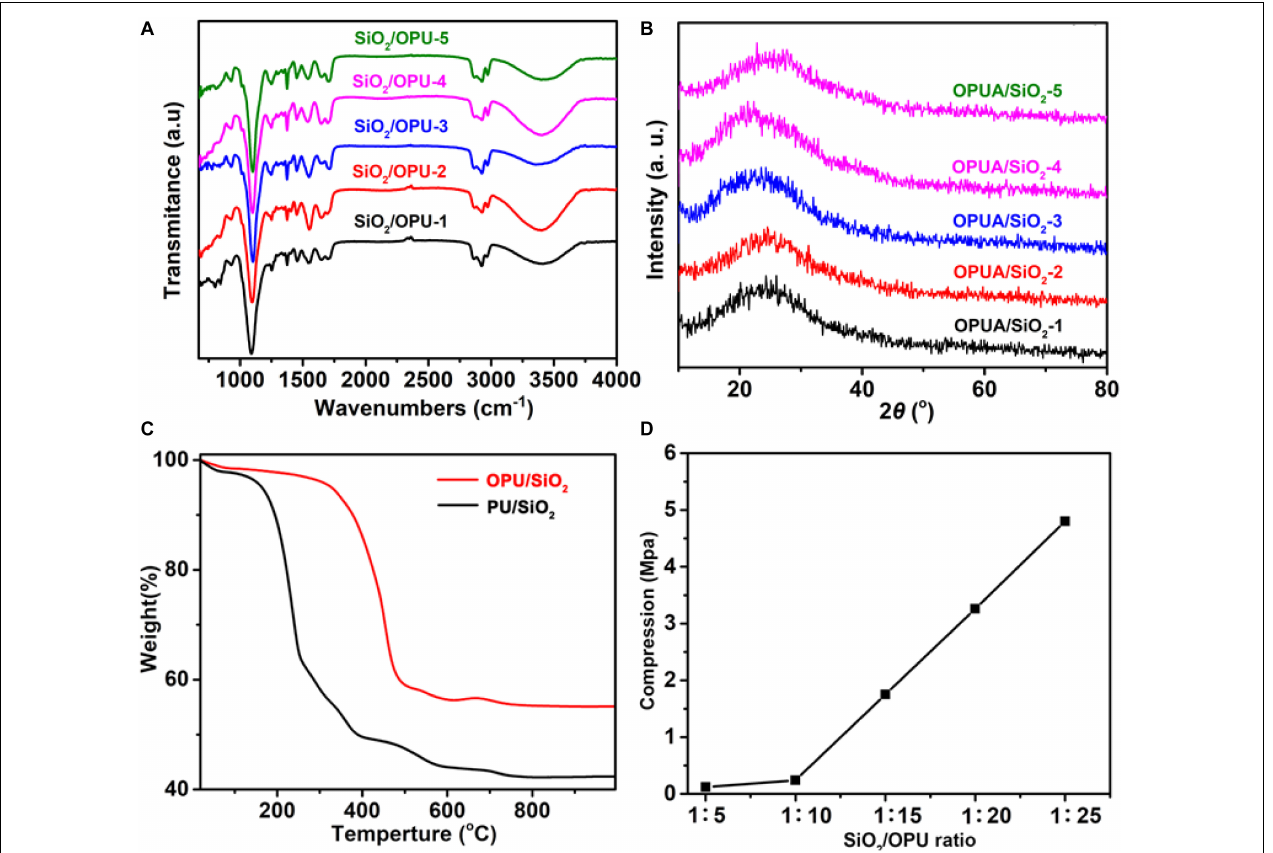
FIGURE 3 | FITR spectra (A) , XRD patterns (B) , thermogravimetric curves (C) , and compression strength (D) of SiO 2